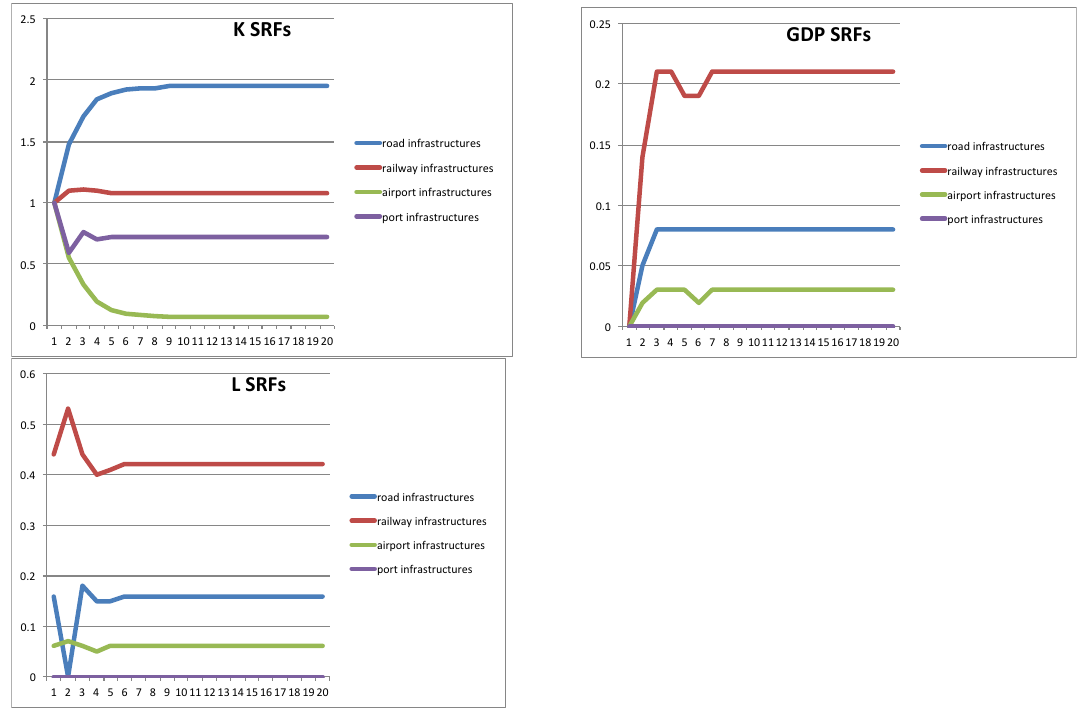
Figure 6. SRF (%) of each variable level to a permanent unitary shock in transportation infrastructures capital stock (road, railways, airport, and port) on GDP, Labor and feedback effects. Notes: SRFs of natural logarithms of each variable. SRFs has been computed adding up IRFs obtained form of model (11) showed in Table 5, as [ ] (Equation 17) until the referenced period. No effects on complementary capital of any of the transportation infrastructures have been